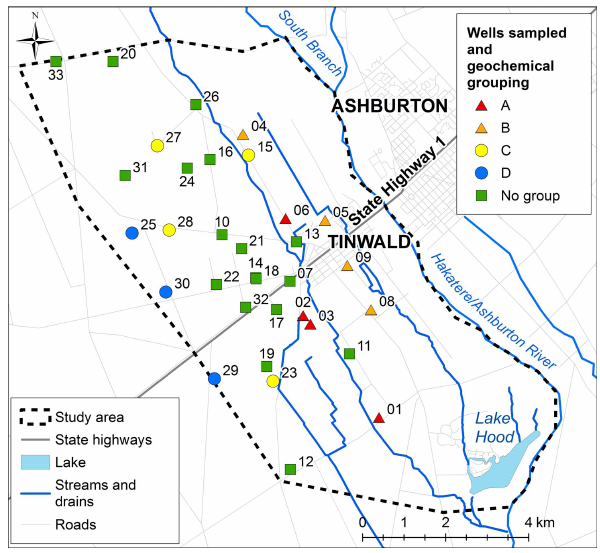
Figure 3. Wells sampled in the Tinwald study area for this study. Base map © LINZ